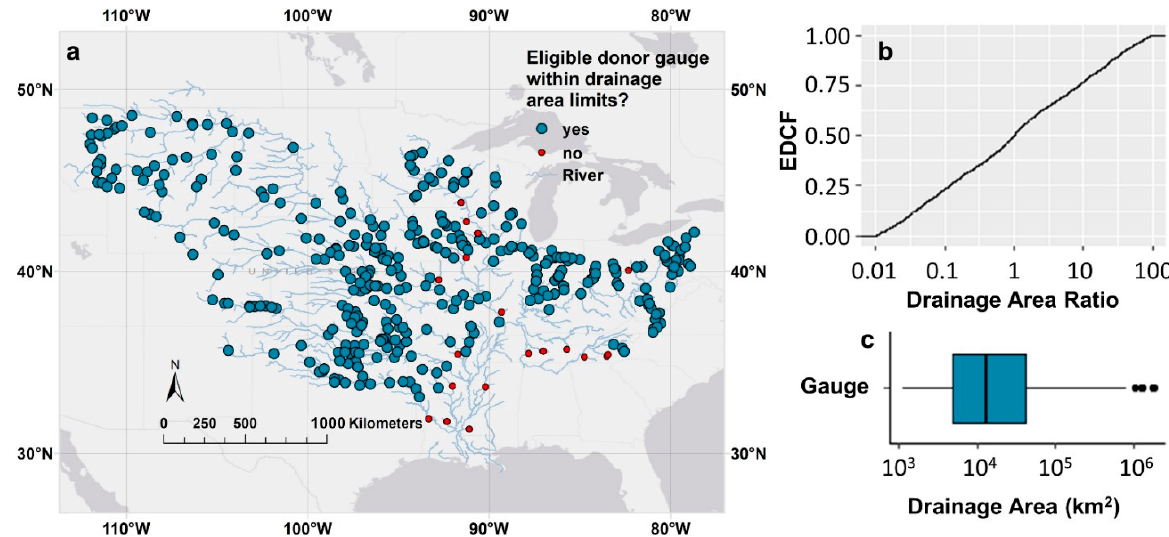
Figure 2. ( a ) 373 USGS gauges in the Mississippi River Network with rivers reaches that have drainage areas greater than 1100 km 2 . The gauges are symbolized by their eligibility to be a donor gauge, meaning they have a drainage area ratio greater than 0.01 or less than 100 with another gauge. ( b ) Histogram and empirical cumulative distribution function (ECDF) of the participating donor gauges’ drainage area ratios with those they donate to. There are 4344 interactions possible within the range from 354 gauges. ( c ) Boxplot of donor gauge drainage areas using the log